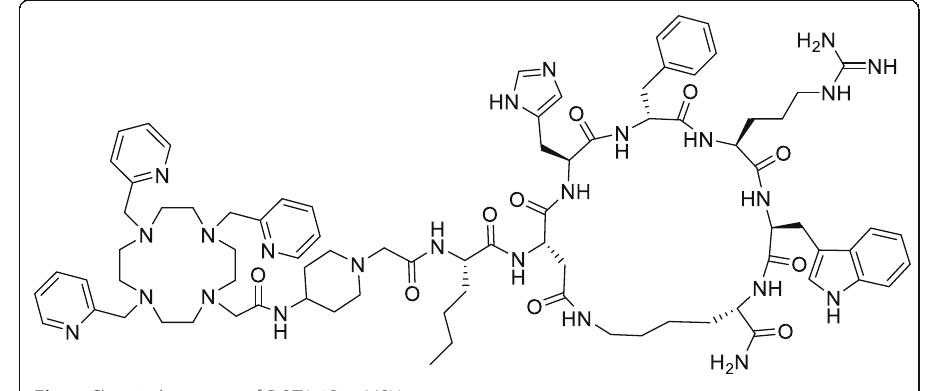
Fig. 5 Chemical structure of DOTA-3Py- α